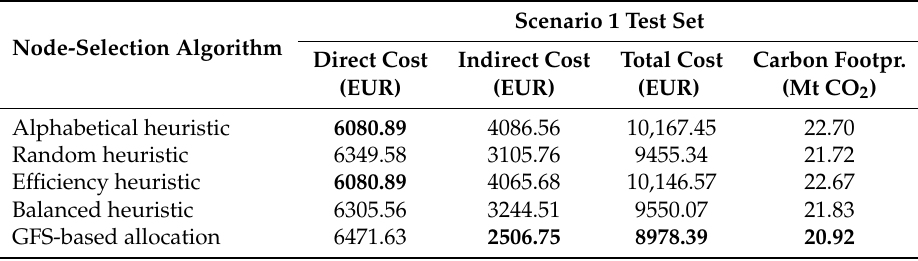
Table 3. Experiment results for the test set of Scenario